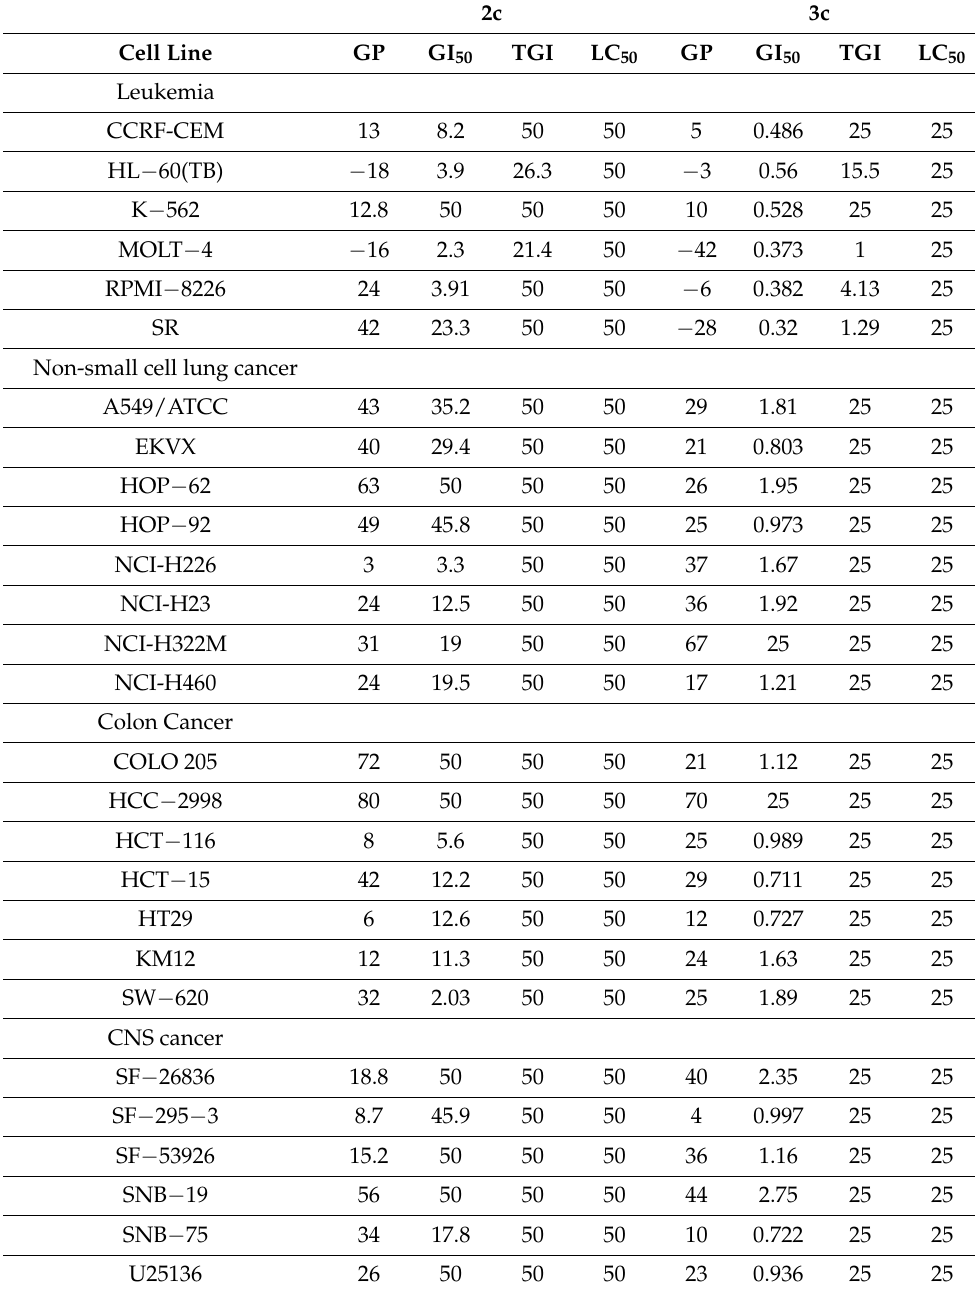
Table 2. Comparison of 2c and 3c compounds, according to their growth present (GP), GI50 ( µ M), TGI, and LC50 values at 100 µ